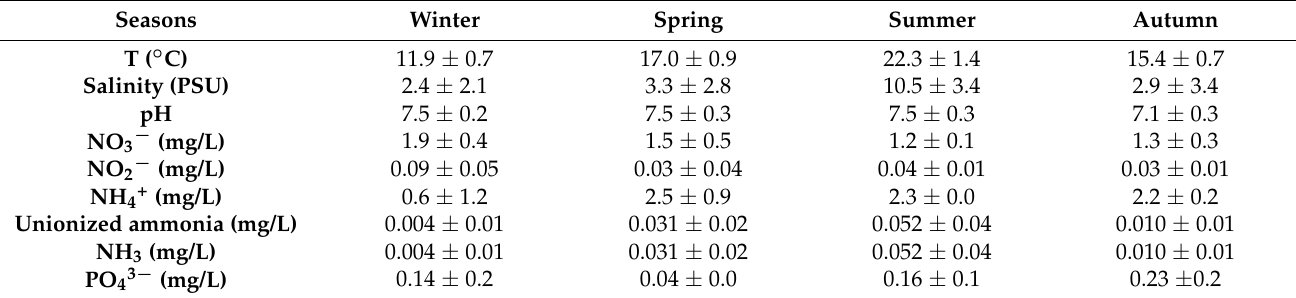
Table 3. Physico-chemical data evaluated in surface waters of the Douro River estuary, presented as mean ± standard